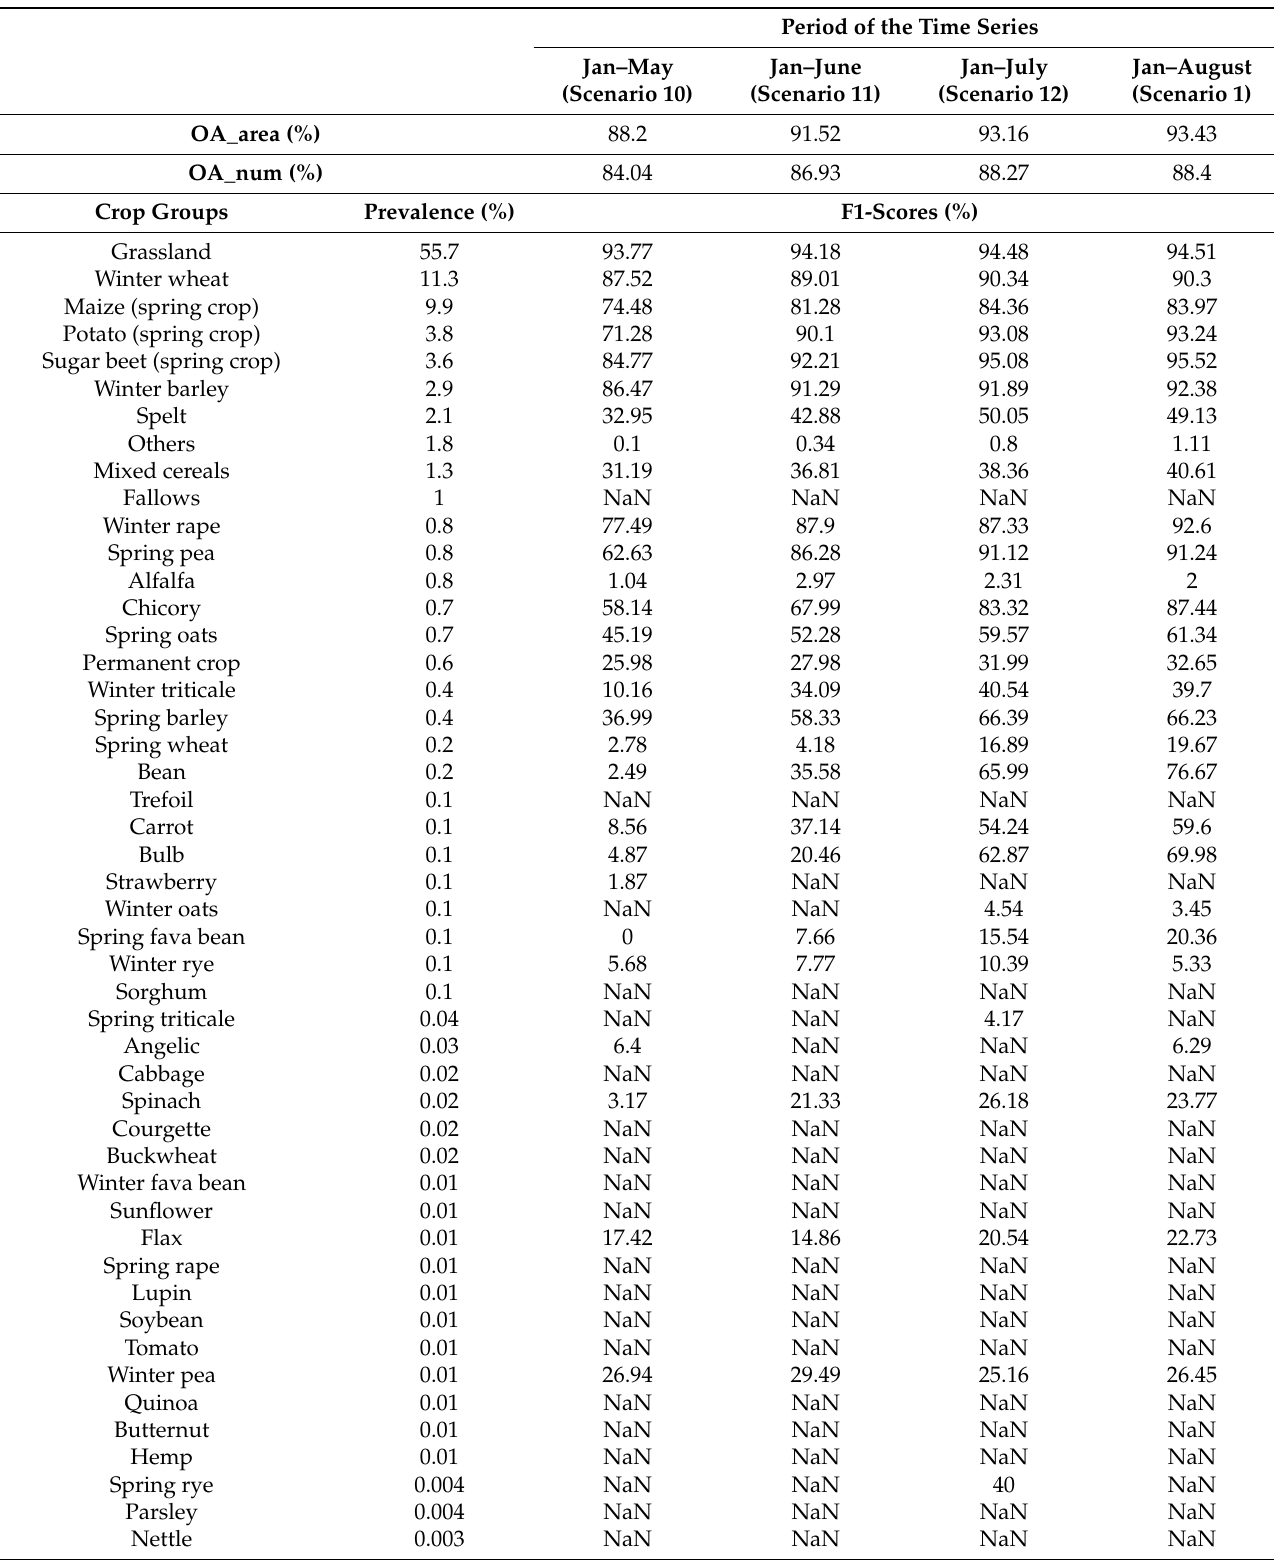
Table 6. Overall Accuracies and crop group F1-scores considering different periods for the SAR time series, beginning in January and ending in May up to